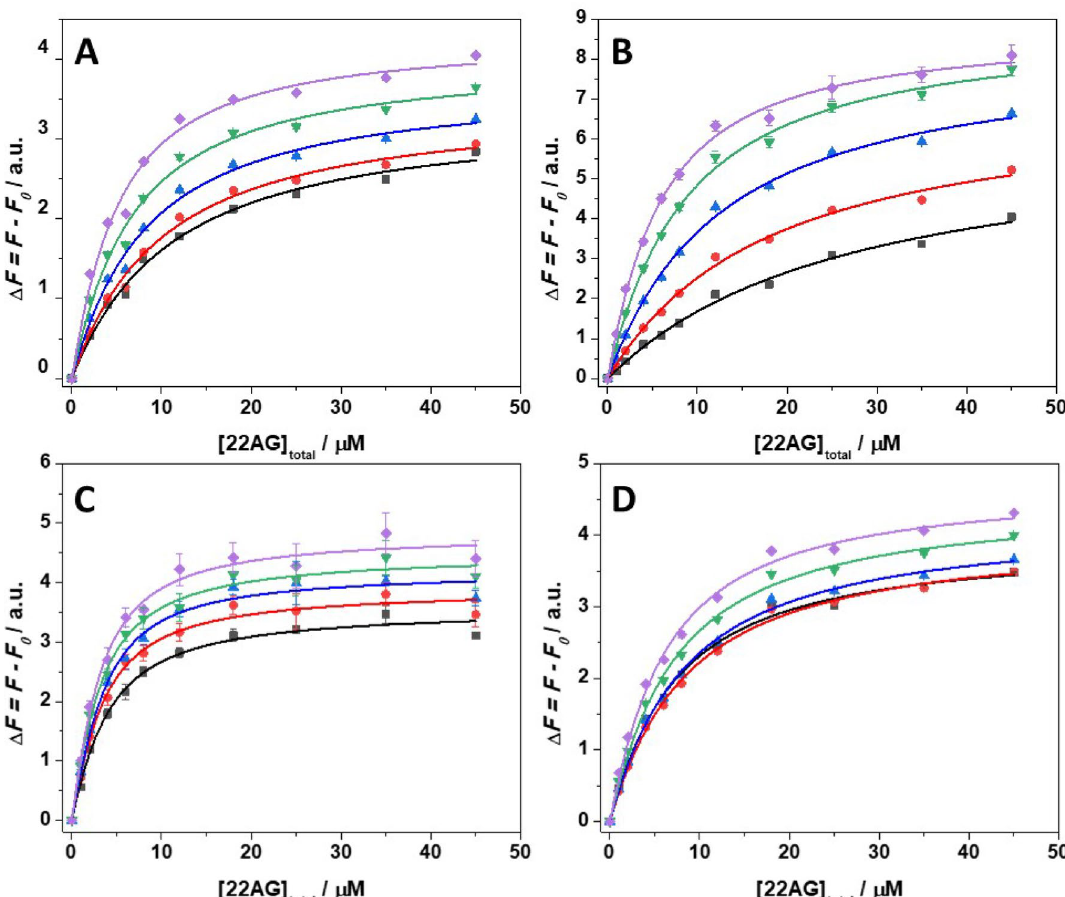
Figure 4. Binding isotherms for the 22AG/ThT system in ( A ) 30 mM Tris, pH 7.4, ( B ) in the presence of 60 mM NaCl, ( C ) in the presence of 60 mM KCl, and ( D ) in the presence of 25 wt% Ficoll at the pressures of: 1 bar (black squares), 500 bar (red circles), 1000 bar (blue triangles), 1500 bar (green reversed triangles), and 2000 bar (violet diamonds). All the experiments were performed in triplicate at the temperature of 25 °C. Where not shown, the error bars are smaller than the symbol size.